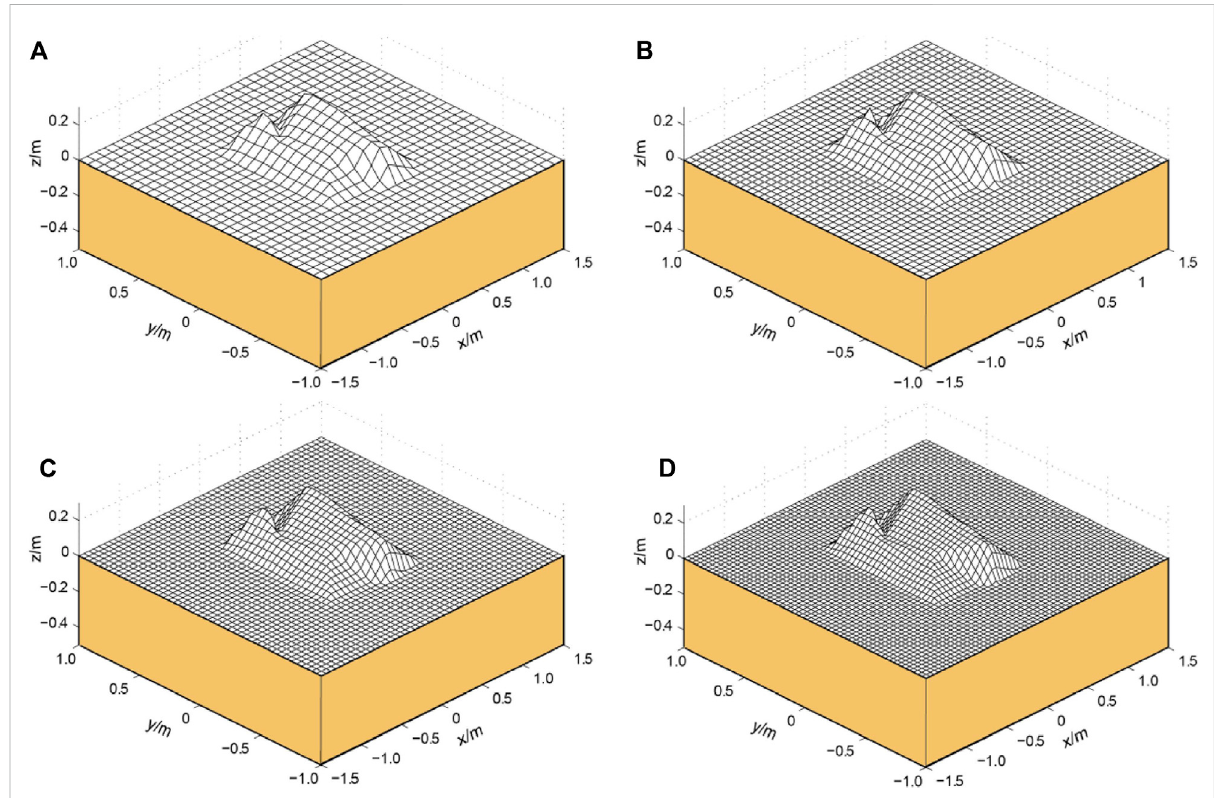
FIGURE 6 The scatter process diagram of three dimensional irregular load model in different grid count n. (A) n = 30; (B) n = 40; (C) n = 50; (D) n = 60.